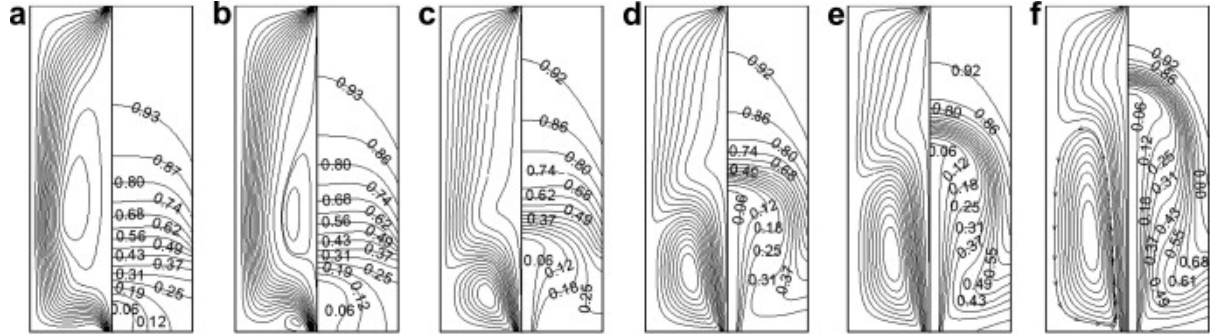
Figure 4. Streamlines (left) and isotherms (right) inside the tank [35]. ( a ) Re = 100; ( b ) Re = 200; ( c ) Re = 400; ( d ) Re = 600; ( e ) Re = 800; ( f ) Re = 1000. Reprinted with permission from ref. [35]. 4 October 2021, Elsevier.